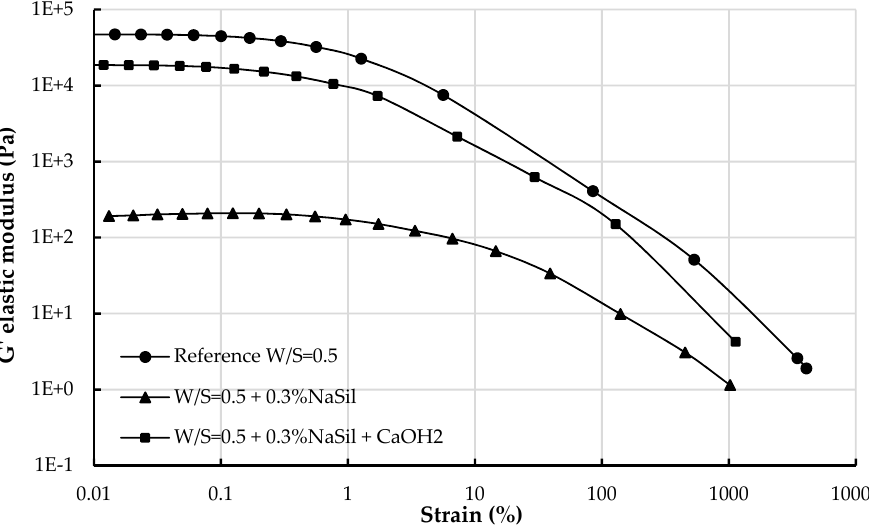
Figure 8. Elastic modulus as a function of strain for the reference earth paste, the earth paste prepared with 0.3% NaSil and the same earth paste containing Ca(OH) 2 after setting.